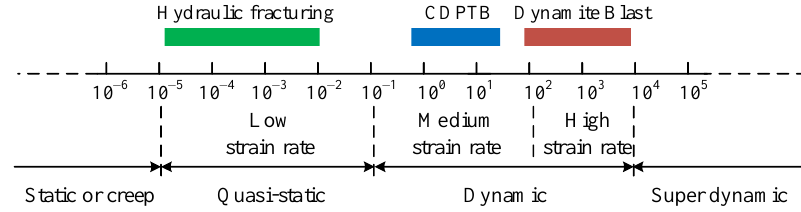
Figure 5. Strain rate classification characteristics and fracture mode distribution.